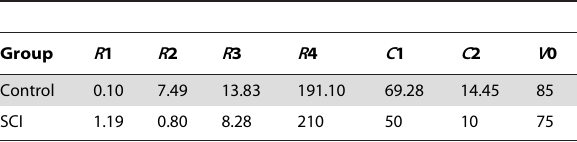
Figure 6. Best-fit parameter ratios for the differential equation part of the model. The x-axis shows the parameter names, and y-axis shows the ratios of parameters for people with and without SCI. The explicit expression of I 2 ( t ) was used for finding best-fit parameters.